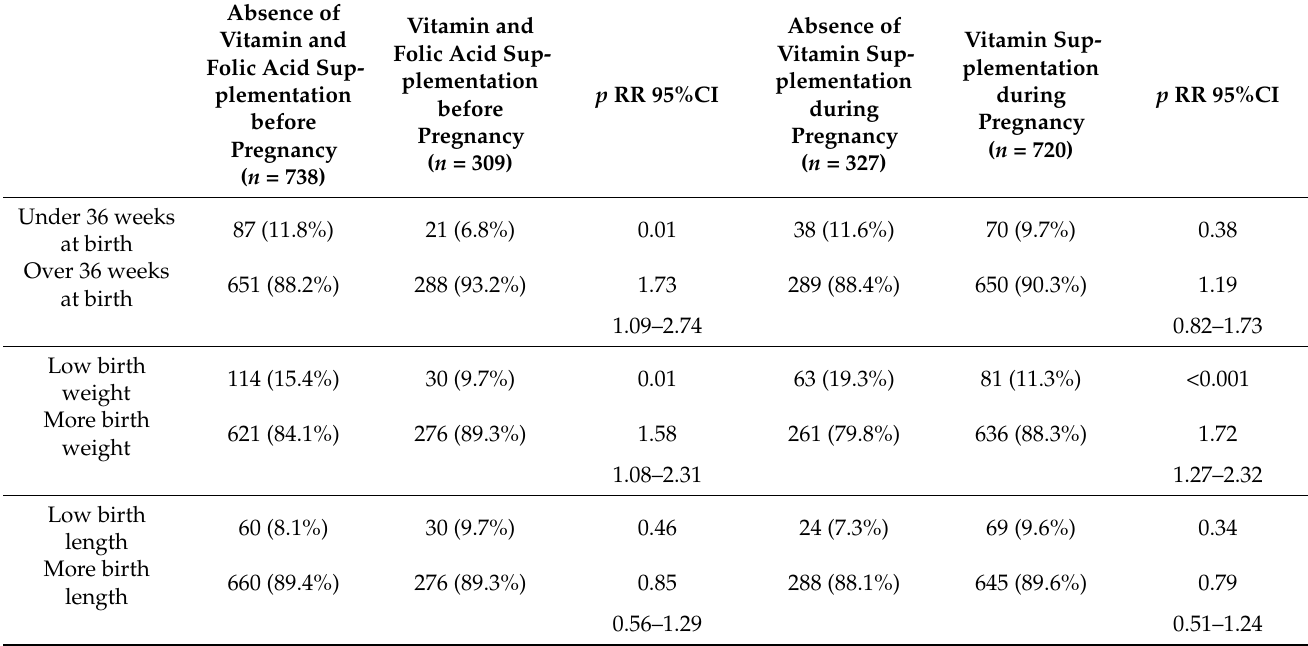
Table 8. Association of supplements intake before and during pregnancy.